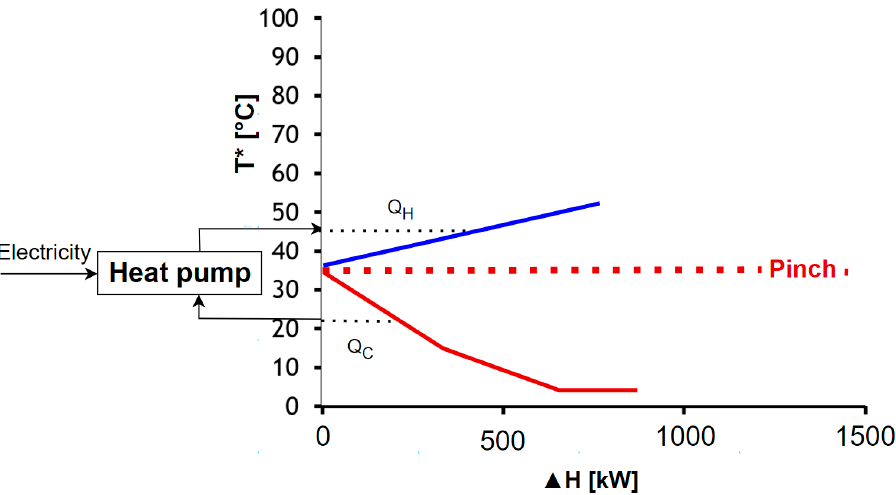
Figure 2. Example of a Grand Composite Curve with an across Pinch placement of a heat pump upgrading excess heat below the Pinch for use above the Pinch [9]. Blue curves indicate process streams that require heating, and red curves indicate process streams that require cooling. T* referring to the shifted temperature.